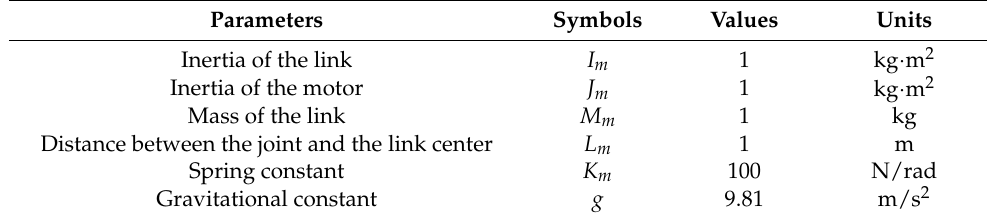
Table 2. Parameters of the flexible-joint